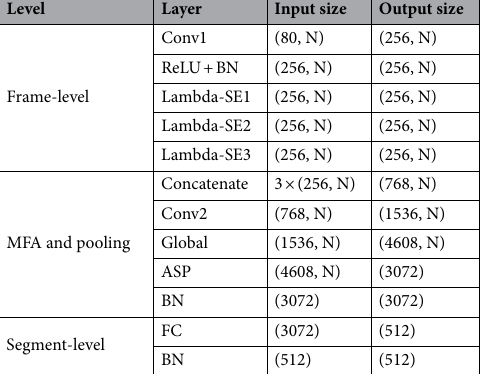
Table 1. Detailed design of proposed Lambda-vector model. N number of input frame-level features, BN batch normalization, Concatenate concatenate in the temporal dimension, ASP attentive statistics pooling, FC fully connected